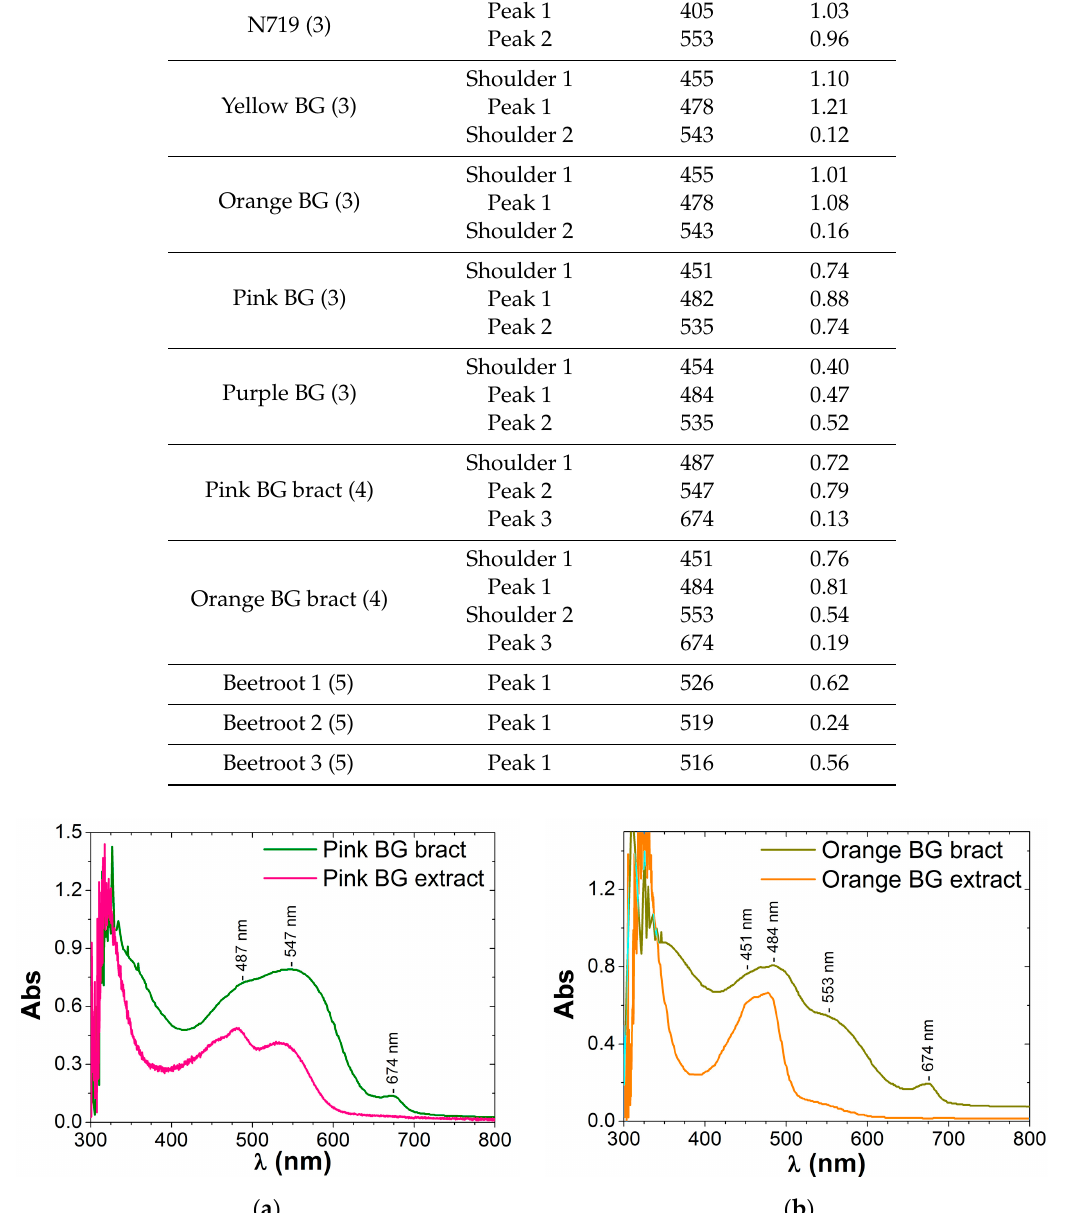
Figure 4. Dry bract and dye extract spectra for: ( a ) pink bougainvillea; ( b ) orange bougainvillea.